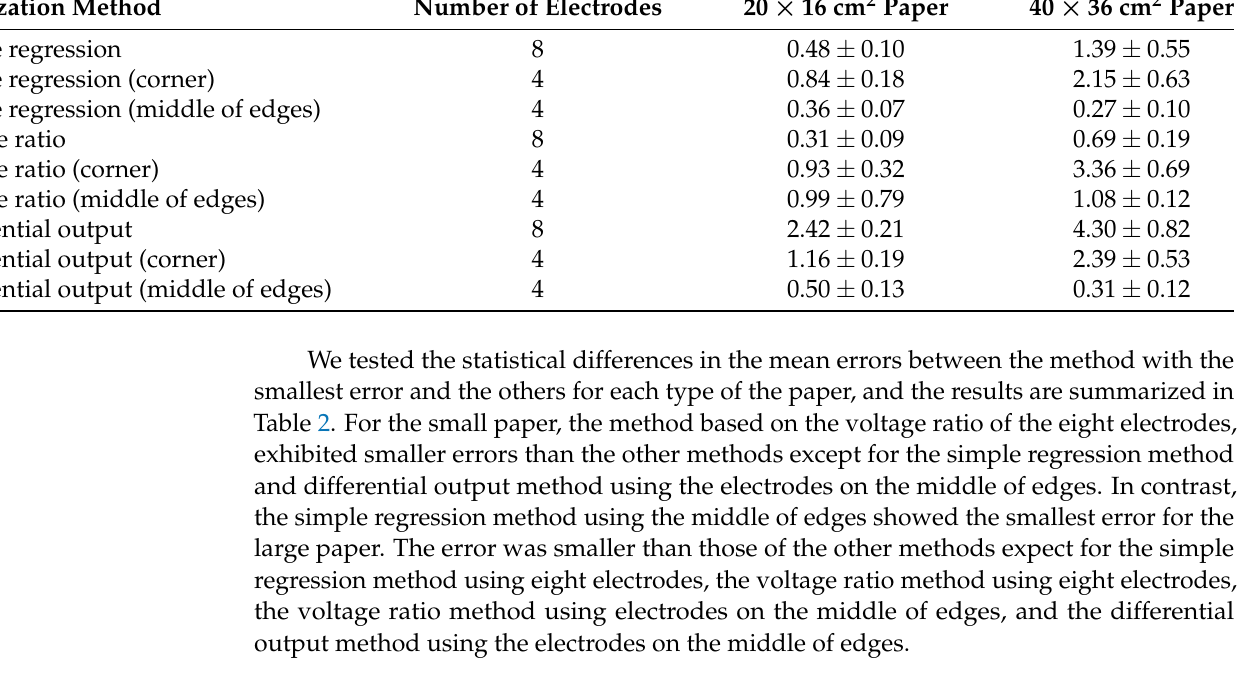
Table 2. t and p values for each paper when the method with the smallest error and the others are statistically compared by t -tests without correction of p values. The degrees of freedom were six for all